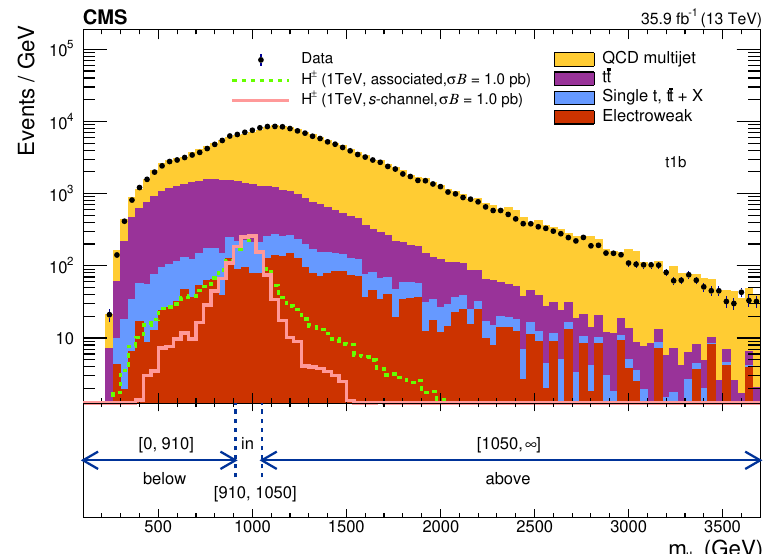
Figure 2 . Data and SM background for the event sample with one t jet as a function of the charged Higgs boson candidate mass. The category t1b is shown and the background normalization is (cid:12)xed to the SM expectation. The signal mass distributions for associated and s -channel production of an H (cid:6) with m = 1 TeV normalized with a cross section times branching fraction of 1 pb are H (cid:6) superimposed as open histograms. The signal mass window \in" for associated production is shown together with the sidebands \below" and \above" for the mass hypothesis of 1 TeV.